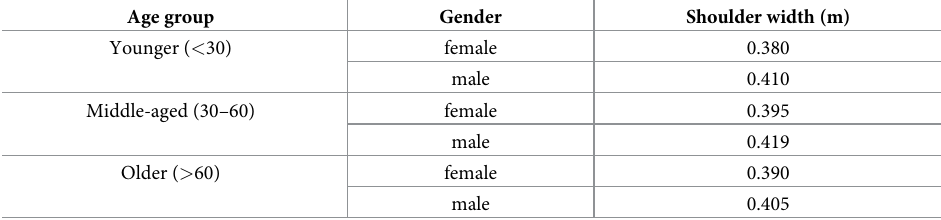
Table 1. Descriptive statistics for demographic information.